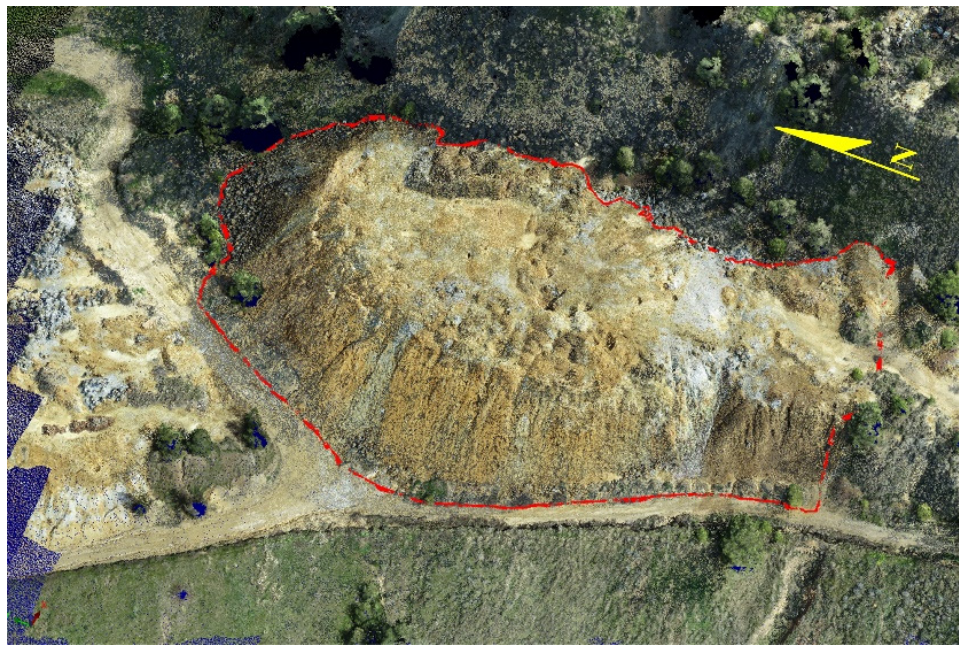
Figure 6. Digitisation of the stockpile boundary on the point cloud dataset.